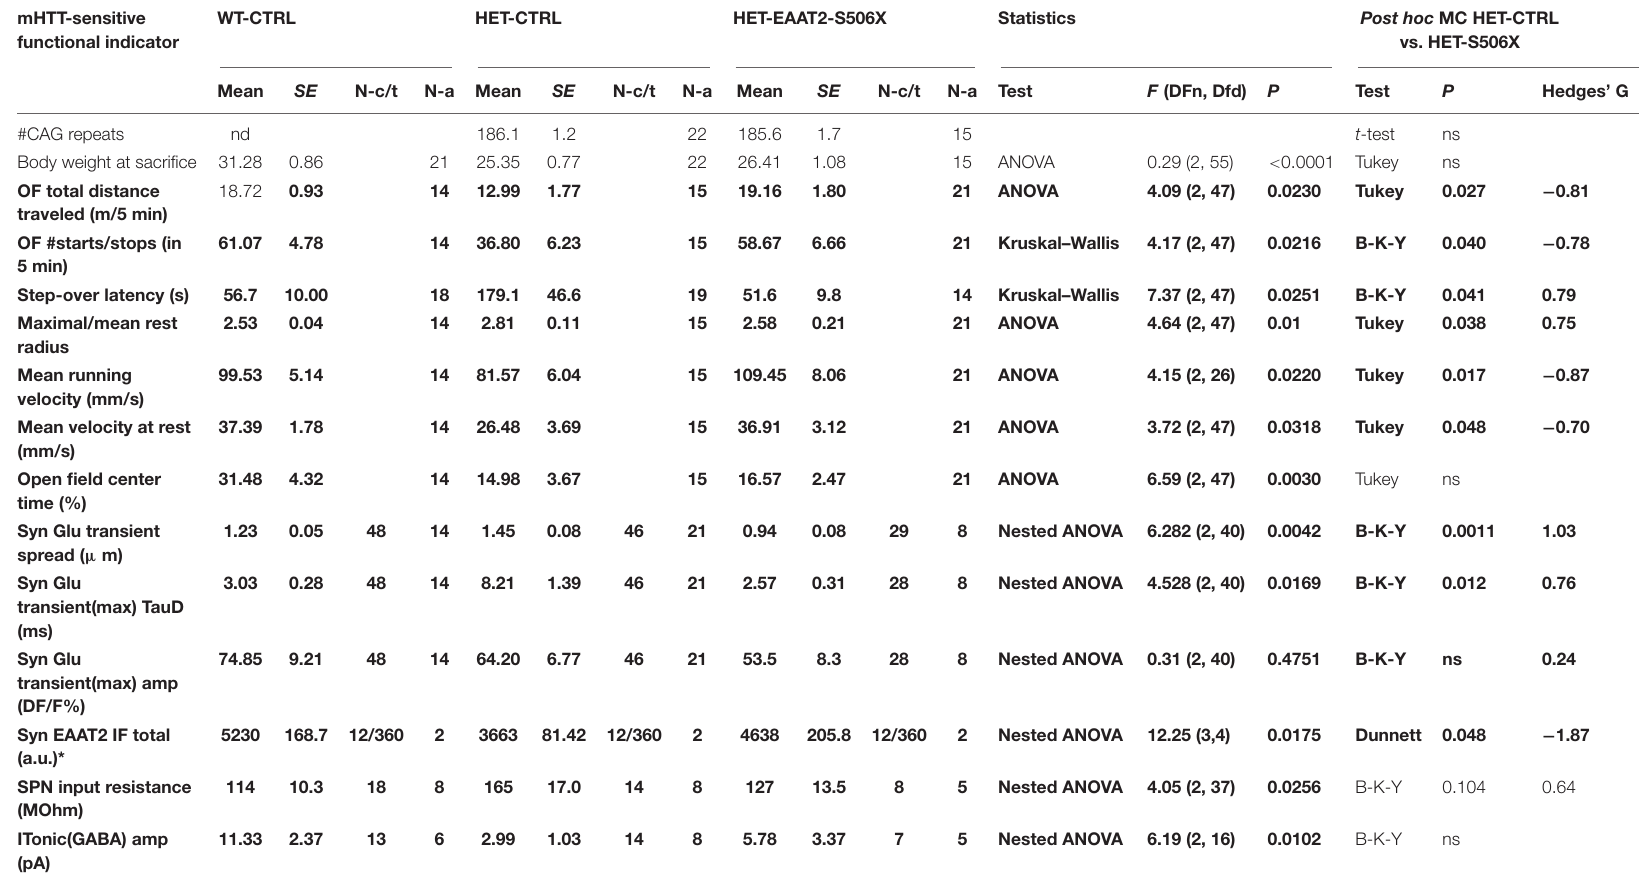
TABLE 2 | Summary of experiments with functional testing. mHTT-sensitive functional